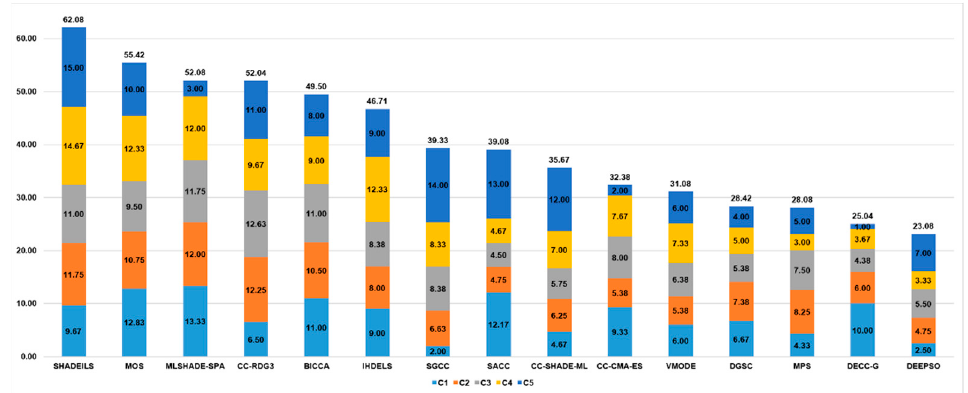
Figure 9. The ranking of CC-SHADE-ML and other state-of-the-art algorithms.